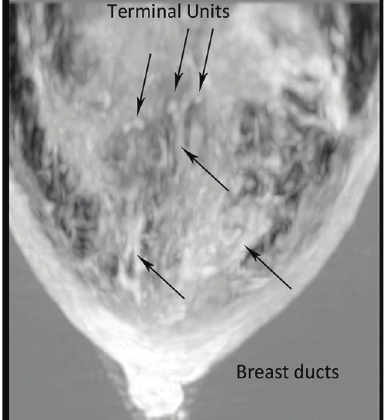
Table 4: Estimated proportion of breasts with better image quality on QT ultrasound by